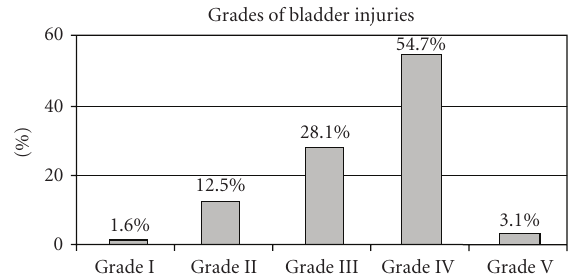
Figure 2: AAST organ injury severity scale grade of 64 penetrating bladder injuries.